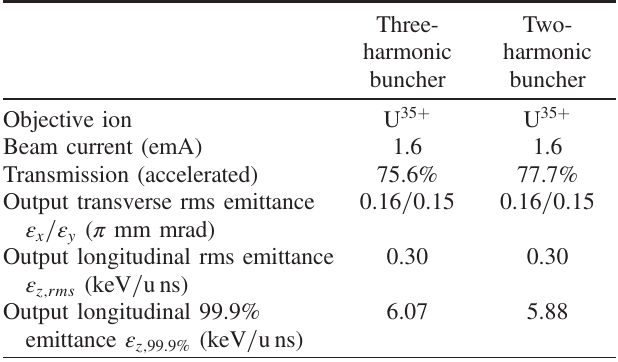
TABLE II. Comparison of beam simulation results between using three-harmonic and two-harmonic prebunchers.